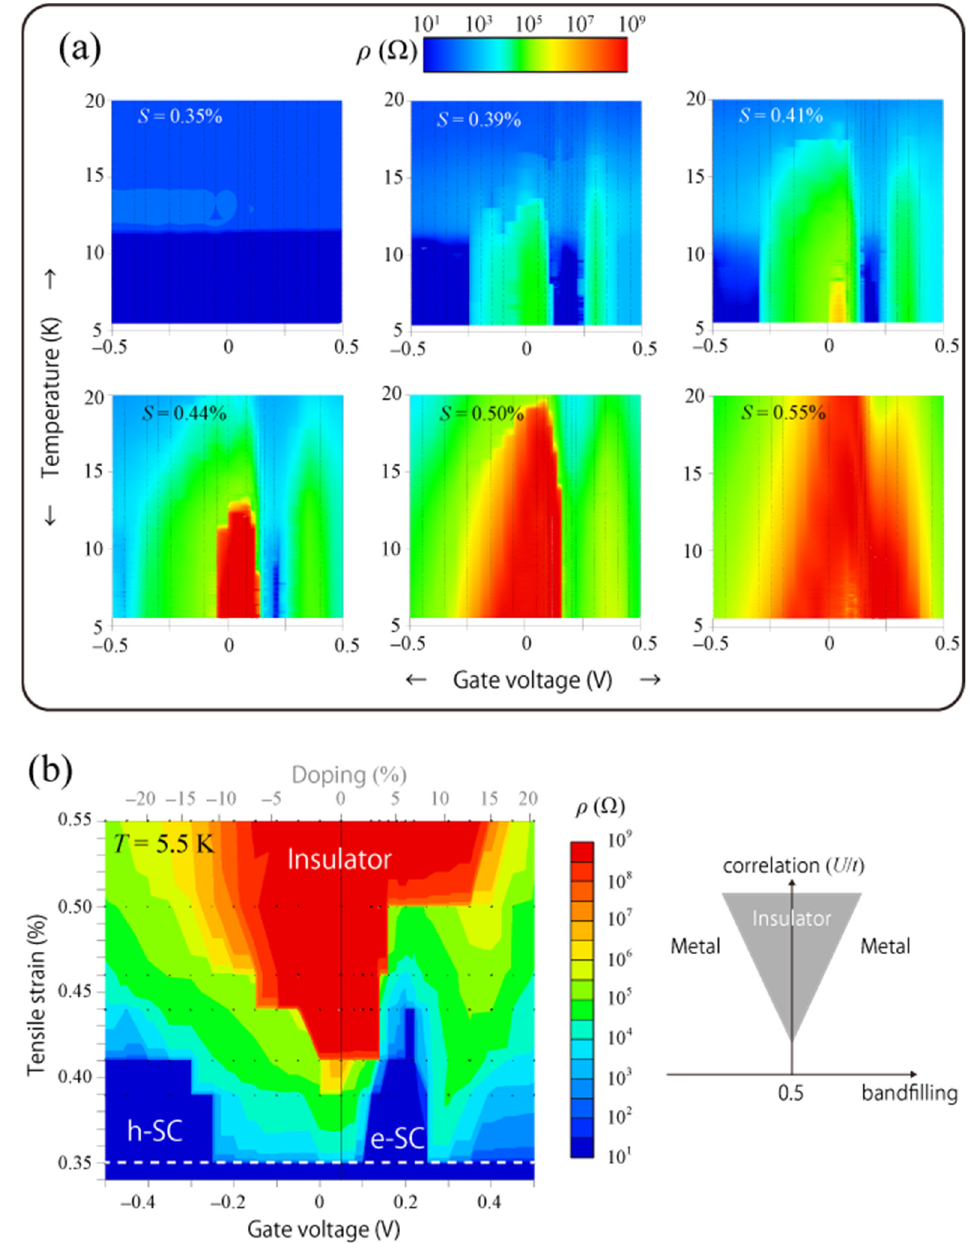
Figure 7. ( a ) Contour plots of sheet resistivity, ρ , under tensile strains, S, of 0.35%, 0.39%, 0.41%, 0.44%, 0.50%, and 0.55% as a function of temperature and gate voltage. ( b ) Contour plots of sheet resistivity, ρ , at 5.5 K as a function of gate voltage and tensile strain (left) and the corresponding conceptual phase diagram (right). Black dots in all figures indicate the data points where the sheet resistivity was measured. The doping concentration estimated from the average density of charge accumulated in the charge displacement current measurement [Figure 3d] is shown for reference on the upper horizontal axis in ( b ).